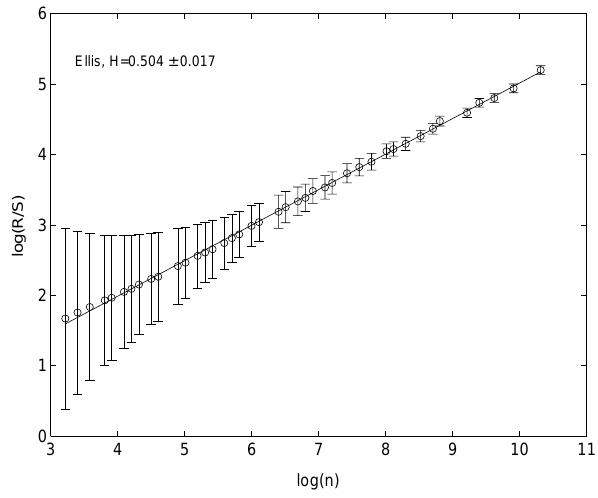
Fig. 4. Range scaling parameter ( R/S ) versus number of obser- vations for the Ellis station. The best-fit line (dashed) results in a Hurst exponent of H R/S = 0 . 504 ± 0 .